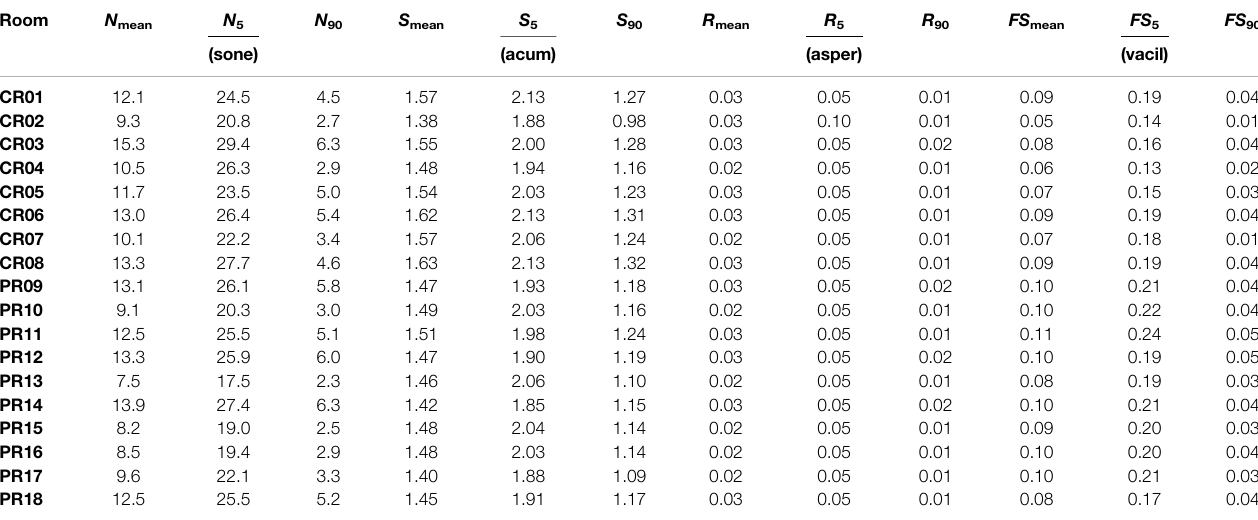
TABLE 6 | In-situ psychoacoustic parameters from omnidirectional microphone.